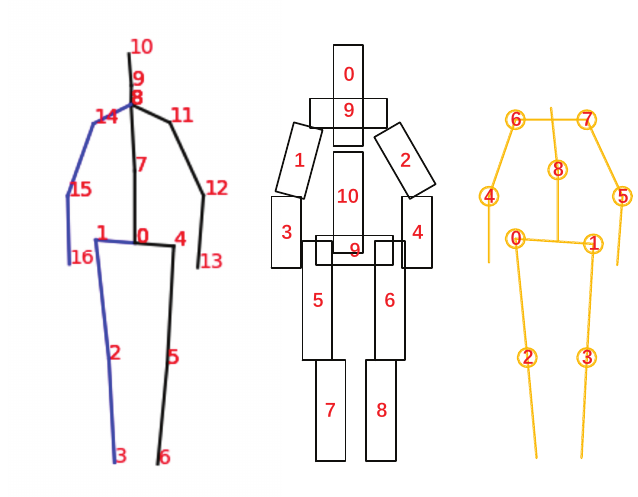
Figure 5. Human pose